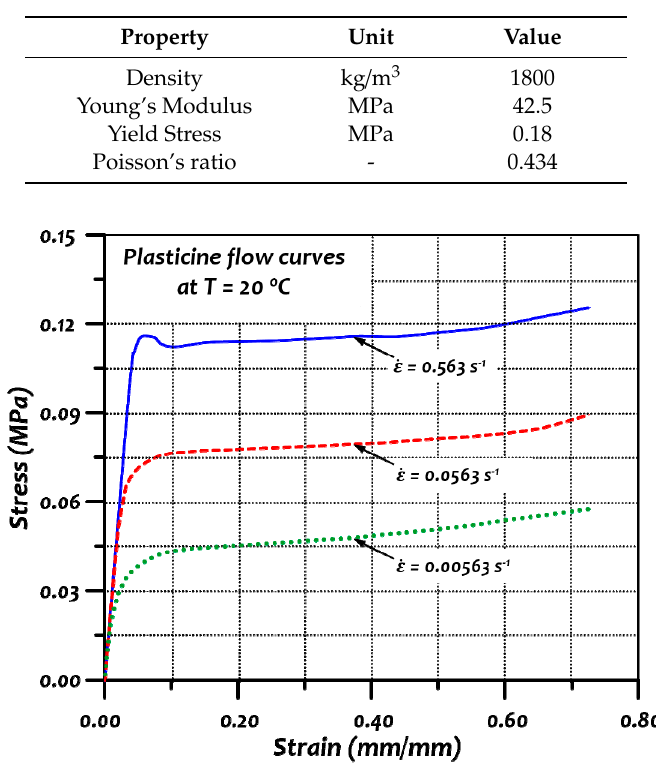
Figure 2. Stress–strain curves of Plasticine at room temperature reproduced from reference [47] with permission from author. permission from